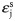
Decoupling classification according to social elasticity.Source. Own elaboration based on Vehmas, Malaska [28] and Tapio [39]. εjs represents the elasticity for social indicators with respect to GNE in each period j. GR¯js stands for the average annual growth rate of each social indicator in period j and GR¯jFD denotes the average annual growth rate of GNE.